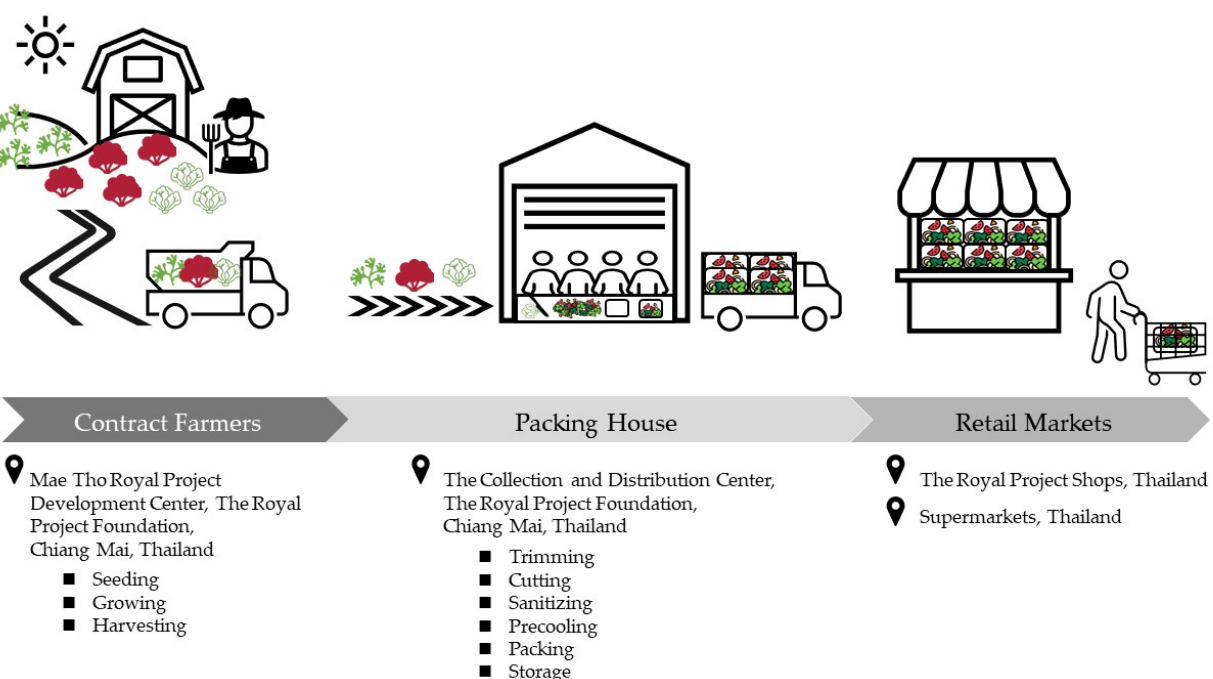
Figure 1. Three ‐ step supply chain of fresh ‐ cut vegetables of the Royal Project Foundation, Thailand. Figure 1. Three-step supply chain of fresh-cut vegetables of the Royal Project Foundation,